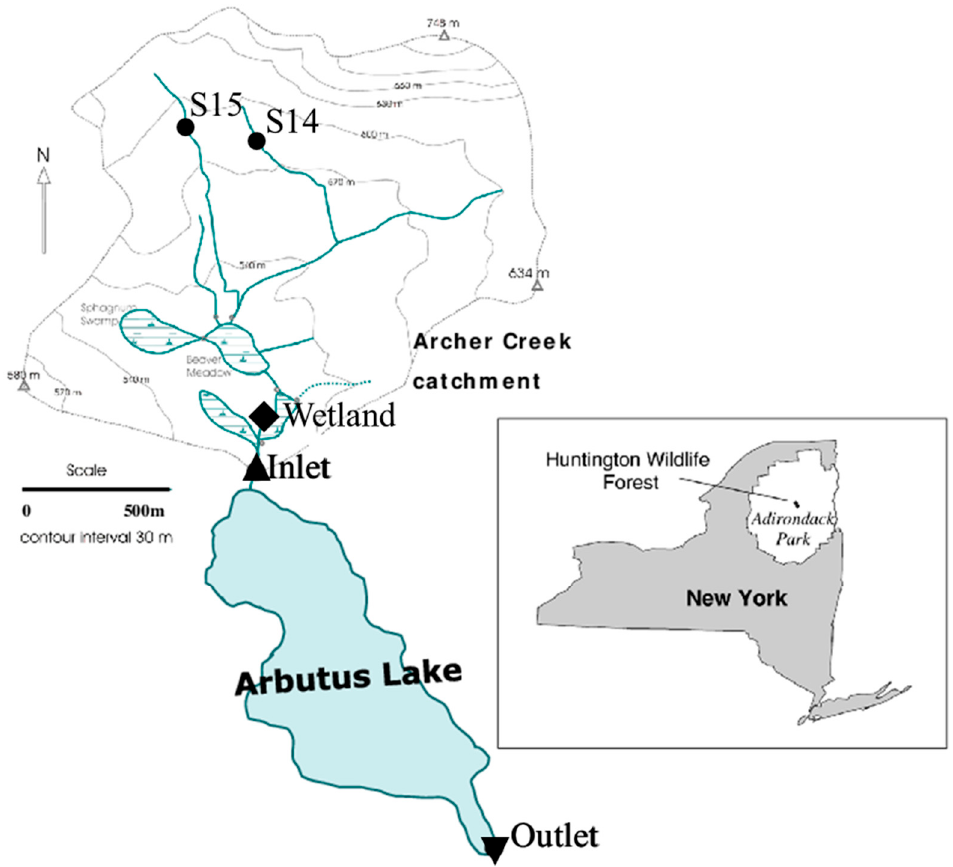
Figure 1. Site map showing the location of surface waters in the Arbutus Lake watershed, Huntington Wildlife Forest, New York.